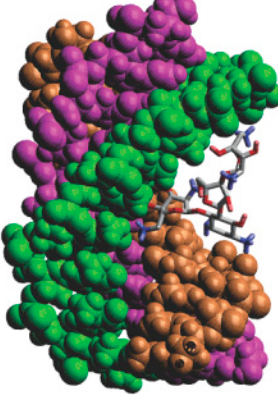
Figure 16. Computer generated model of neomycin bound to a DNA triplex. Ring I of neomycin locates in the middle of the DNA groove, and Ring II and IV facilitate bridging the pyrimidine strands; the orange, green and purple structures represent the three chains of the DNA; the blue and red atoms in the molecule represent nitrogen and oxygen atoms, respectively.